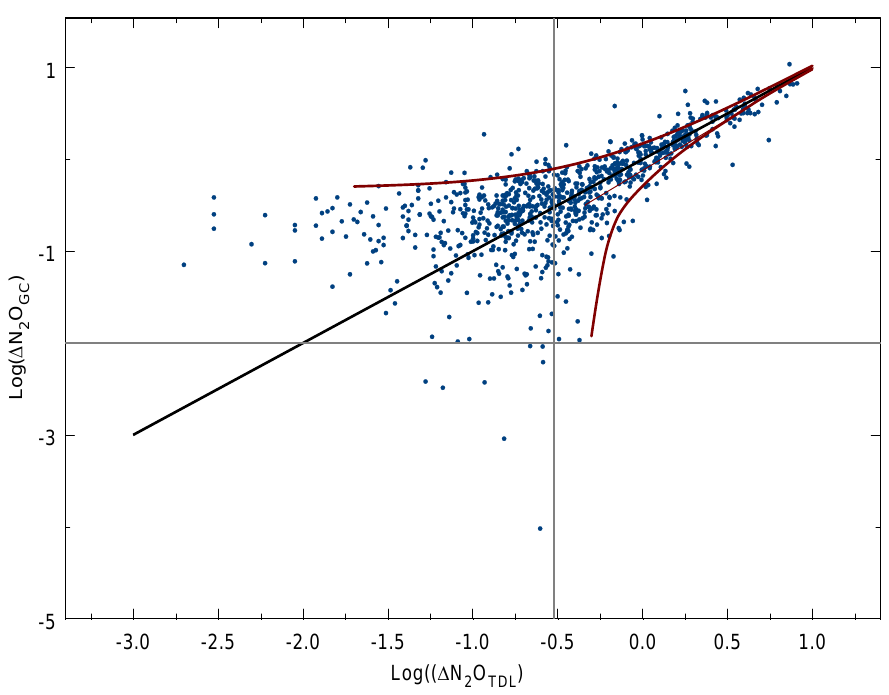
Figure 5. 3 Fig. 5. Scatter plot comparison between the Log (of ppb) TDL-based difference 1 N 2 O TDL and GC-based difference 1 N 2 O GC in N 2 O mixing ratio. The diagonal line shows 1:1 relationship. The precision level of the TDL (0.01 ppb) and GC based system (0.3 ppb) are shown by vertical and horizontal lines, respectively. The curved lines show an envelope of ± 0.5 ppb on the GC